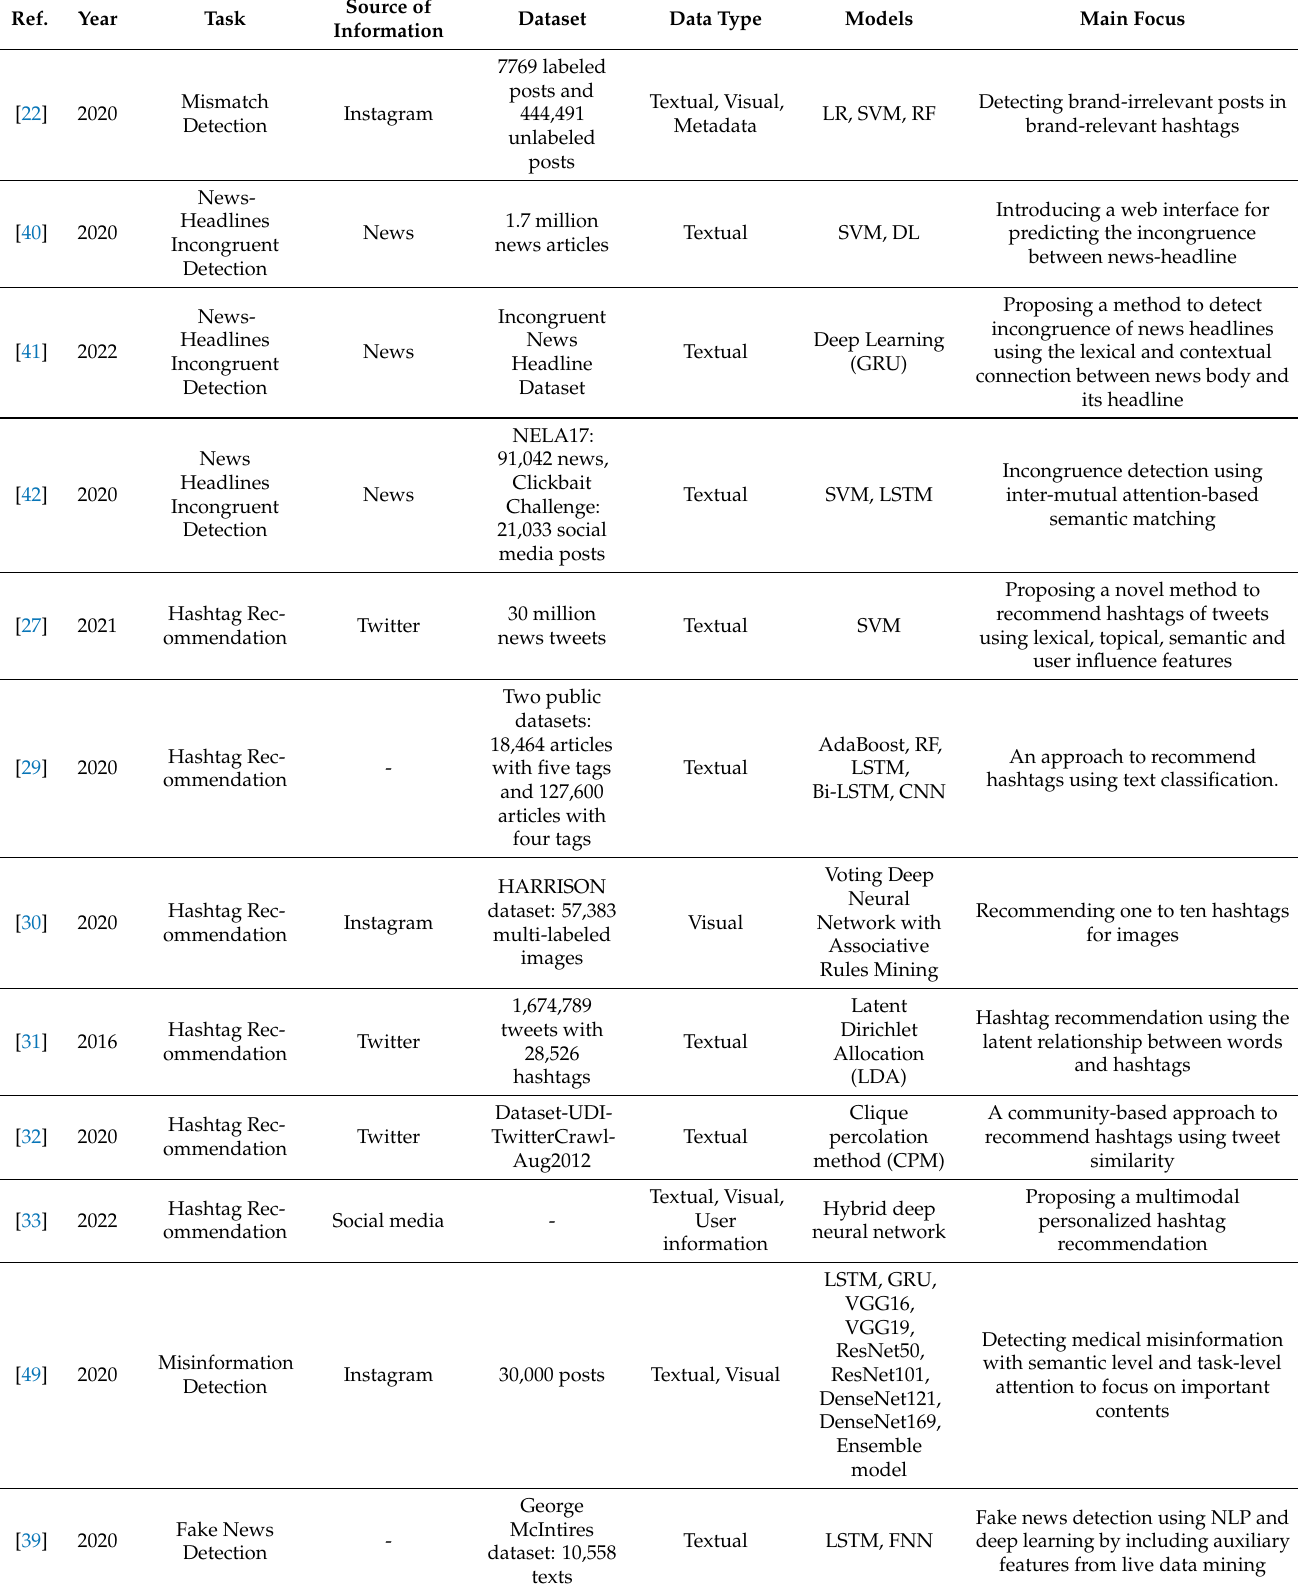
Table 1. A summary and comparison of the main characteristics of related ML models in the literature.